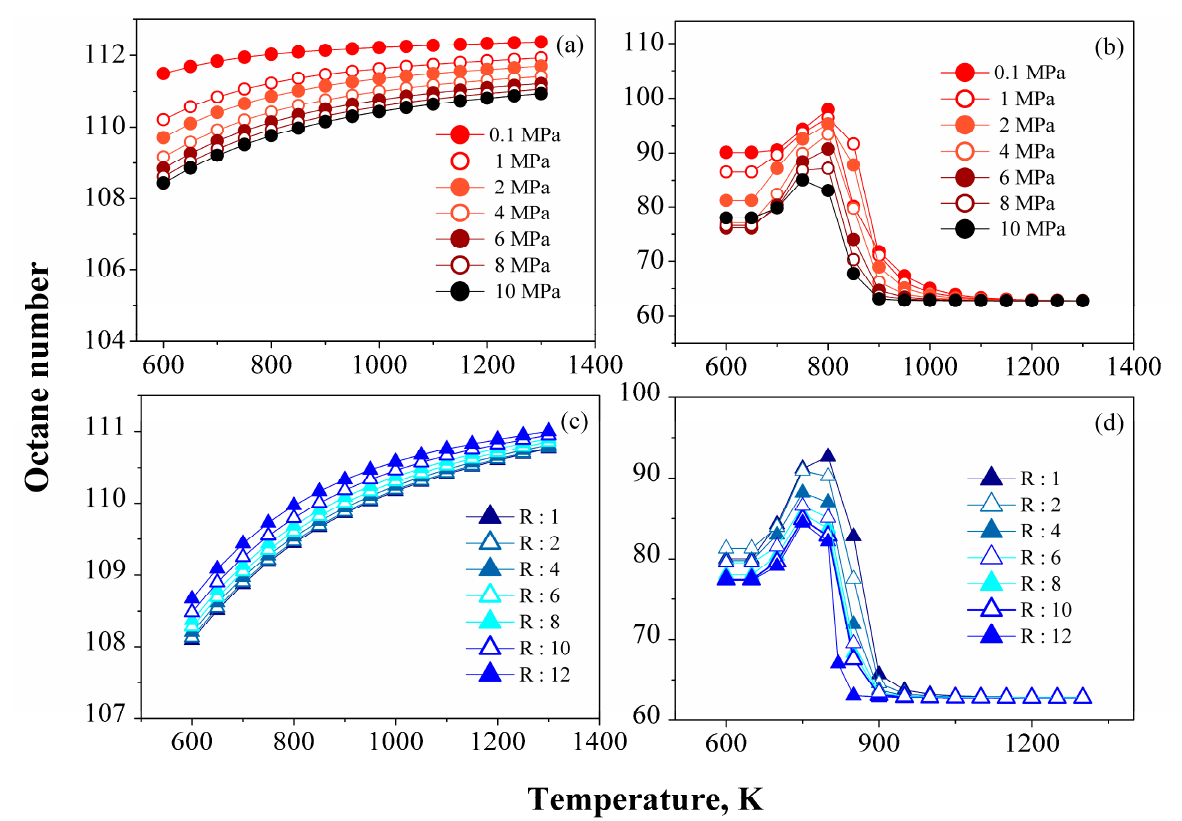
Figure 9. Effect of operating conditions on the Research Octane Number. Effect of pressure: ( a ) Equi- librium, ( b ) Catalytic. Effect of H 2 /H ratio (10 MPa): ( c ) Equilibrium, ( d ) Catalytic.